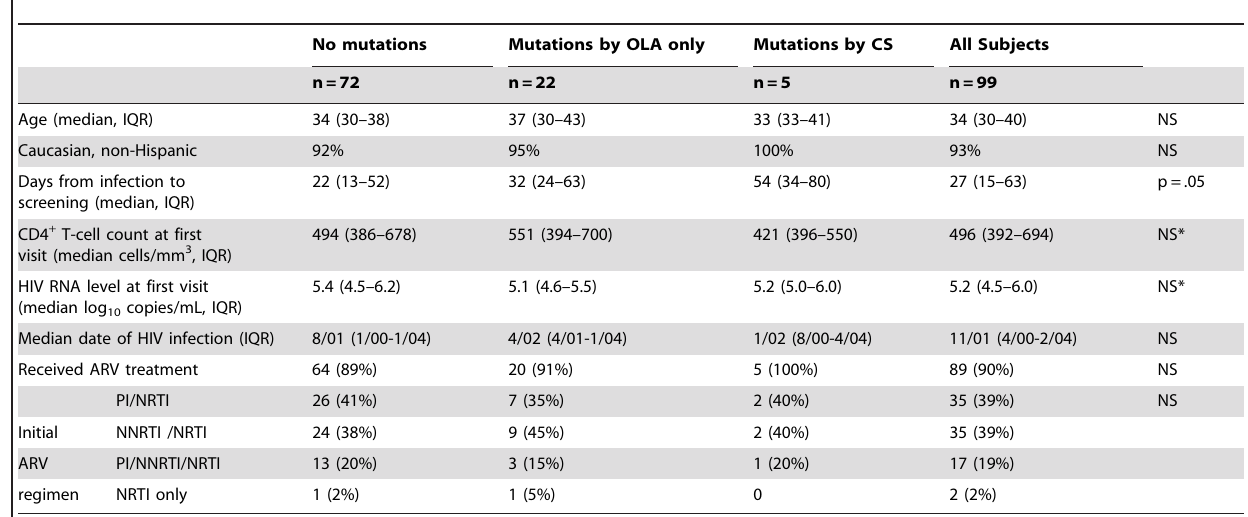
Table 1. Characteristics of study subjects with primary HIV-1 infection evaluated for drug resistance mutations.